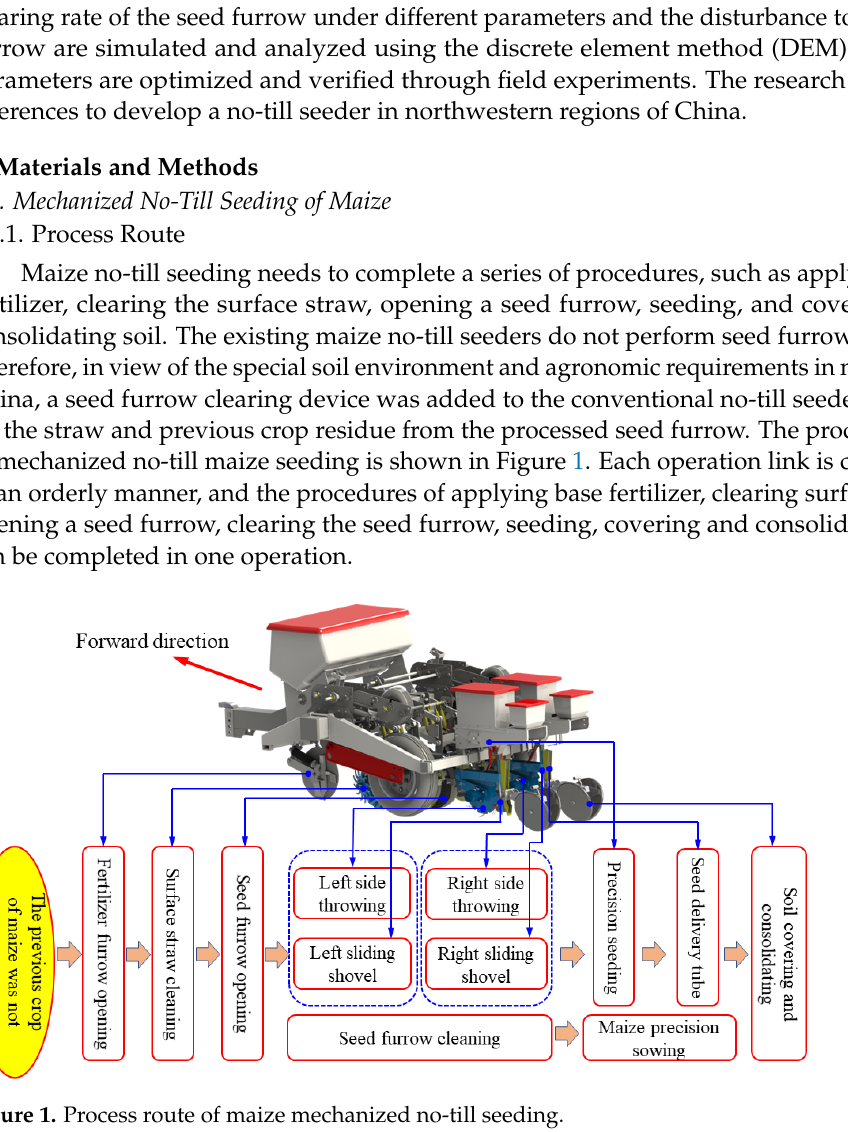
Figure 1. Process route of maize mechanized no-till